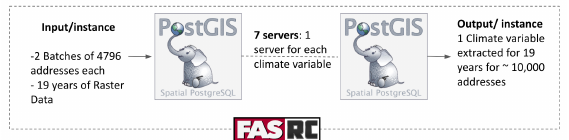
Figure 4 . Scaling the process on High Performance Compute Cluster using PostGIS